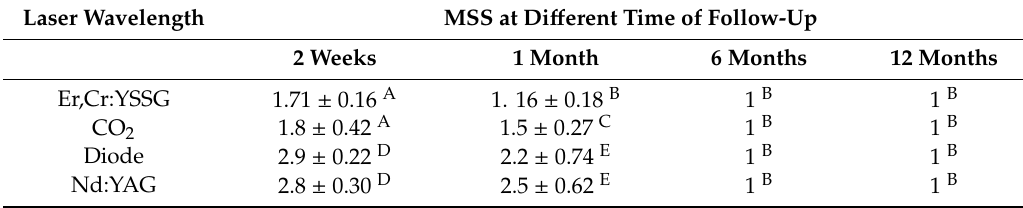
Table 4. Global mean value of the Manchester scar score at di ff erent follow-ups as a function of the laser